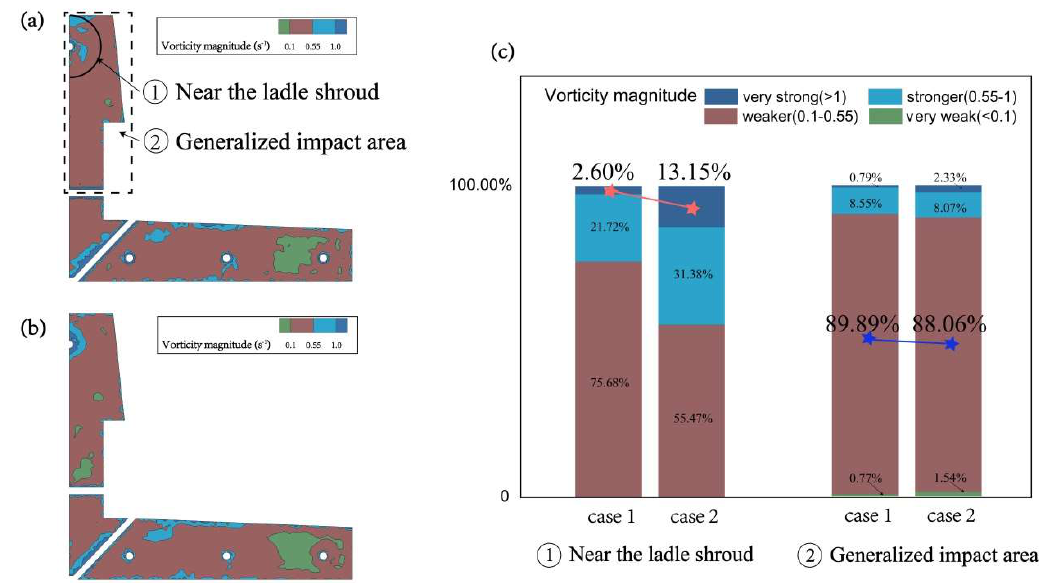
Figure 8. At 850 s, vorticity distribution in ( a ) case 1 and ( b ) case 2; ( c ) the ratio of vorticity magnitude in di ff erent study regions.